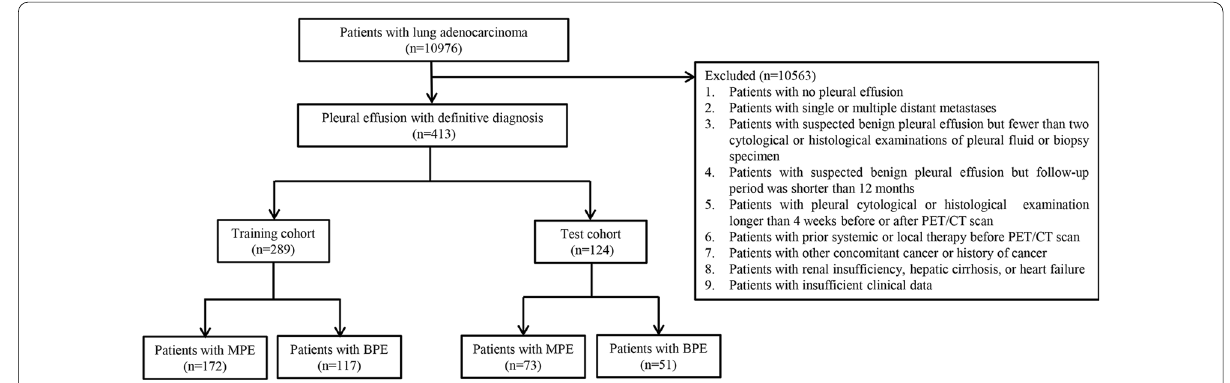
Fig. 1 Flowchart of the search strategy and study